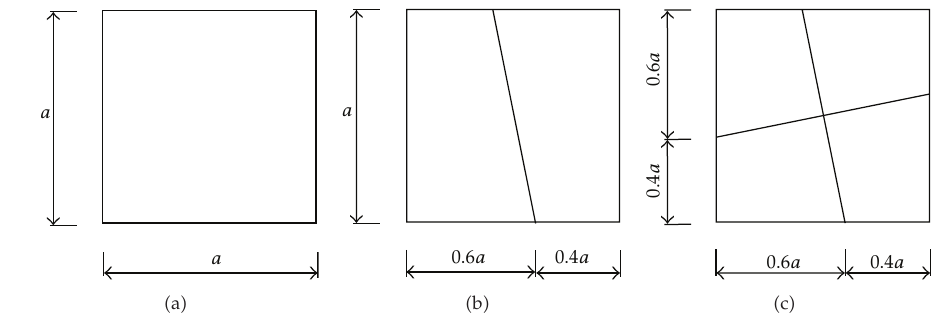
Figure 3: The 3 meshes adopted for the square plate.